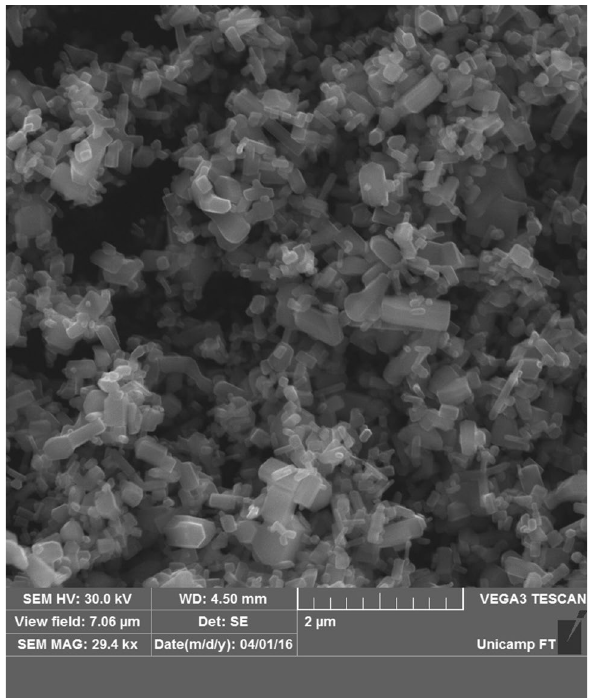
Figure 2. Surface morphology of ZnO NPs by SEM. 2 µm scale bar; 29.0 kx magnification.